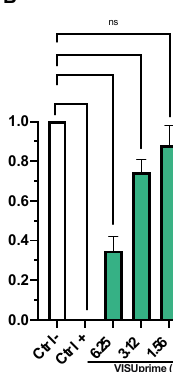
Figure 9. Virus pretreatment with Oftasecur ( A ) and Visuprime ( B ) against GFP-engineered HSV-1. The fluorescence signal was read at the excitation wavelength of 395 nm and the emission wavelength of 509 nm. ( A ): (****: p -value < 0.0001, ***: p -value = 0.0007, **: p -value = 0.0063; ns: p -value = 0.1300); ( B ): (****: p -value < 0.0001, ***: p -value = 0.0004, *: p -value = 0.0255; ns: p -value =